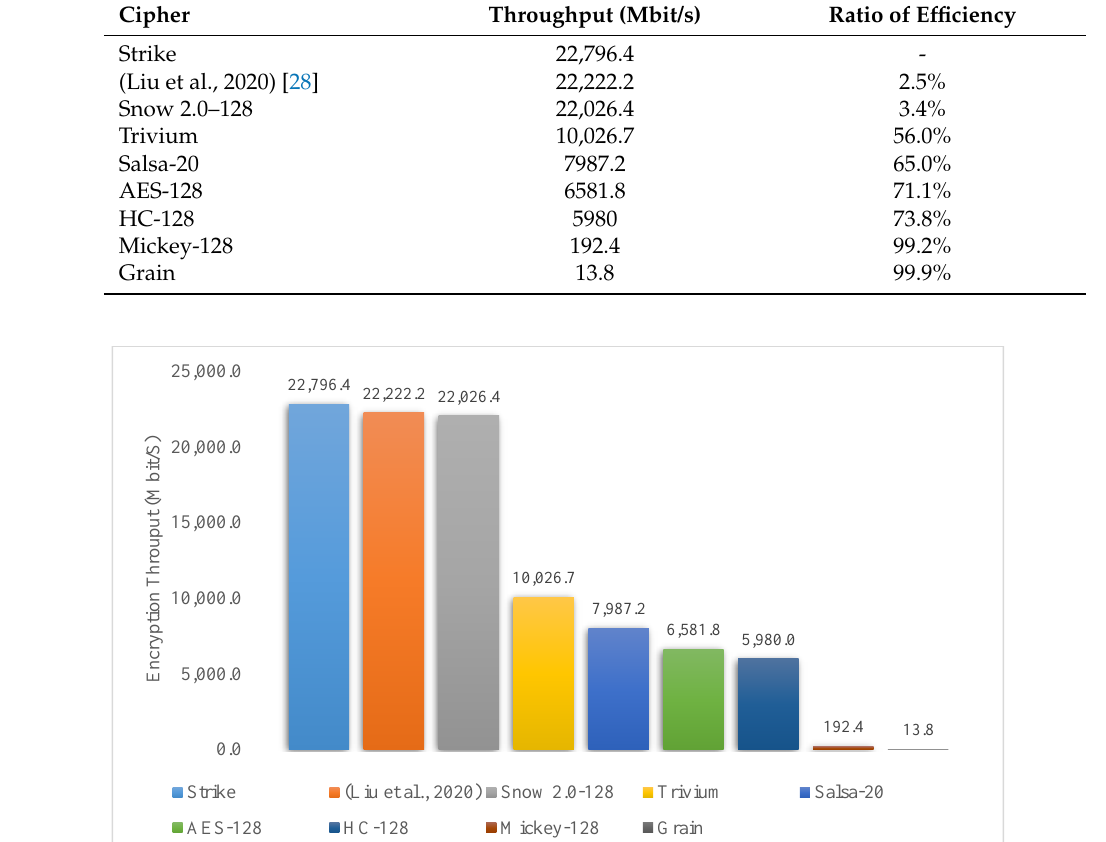
Table 8. Stream ciphers performance results on M1.